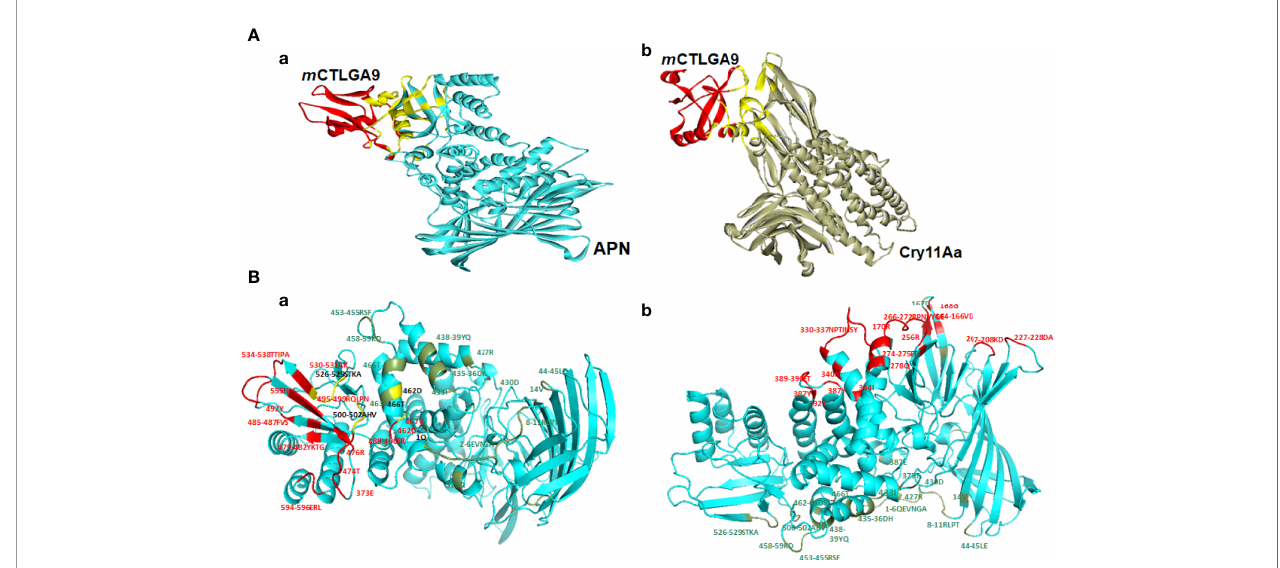
FIGURE 2 | Molecular docking of mutant CTLGA9 with APN and Cry11Aa. Three-dimensional structures were modeled using Phyre-2 engine and molecular docking was performed by Discovery Studio 2.5. (A-a) Binding sites (yellow color) in docking complexes of m CTLGA9 with APN and (A-b) Cry11Aa. (B) Binding interface in APN receptor. (B-a) Residues in APN that are involved in interaction with wt CTLGA9 (colored in red) and Cry11Aa (colored in green) while yellow color showed common binding sites of both CTLGA9 and Cry11Aa in APN receptor interface (B-b) Residues in APN that are involved in interaction with m CTLGA9 (colored in red) and Cry11Aa (colored in